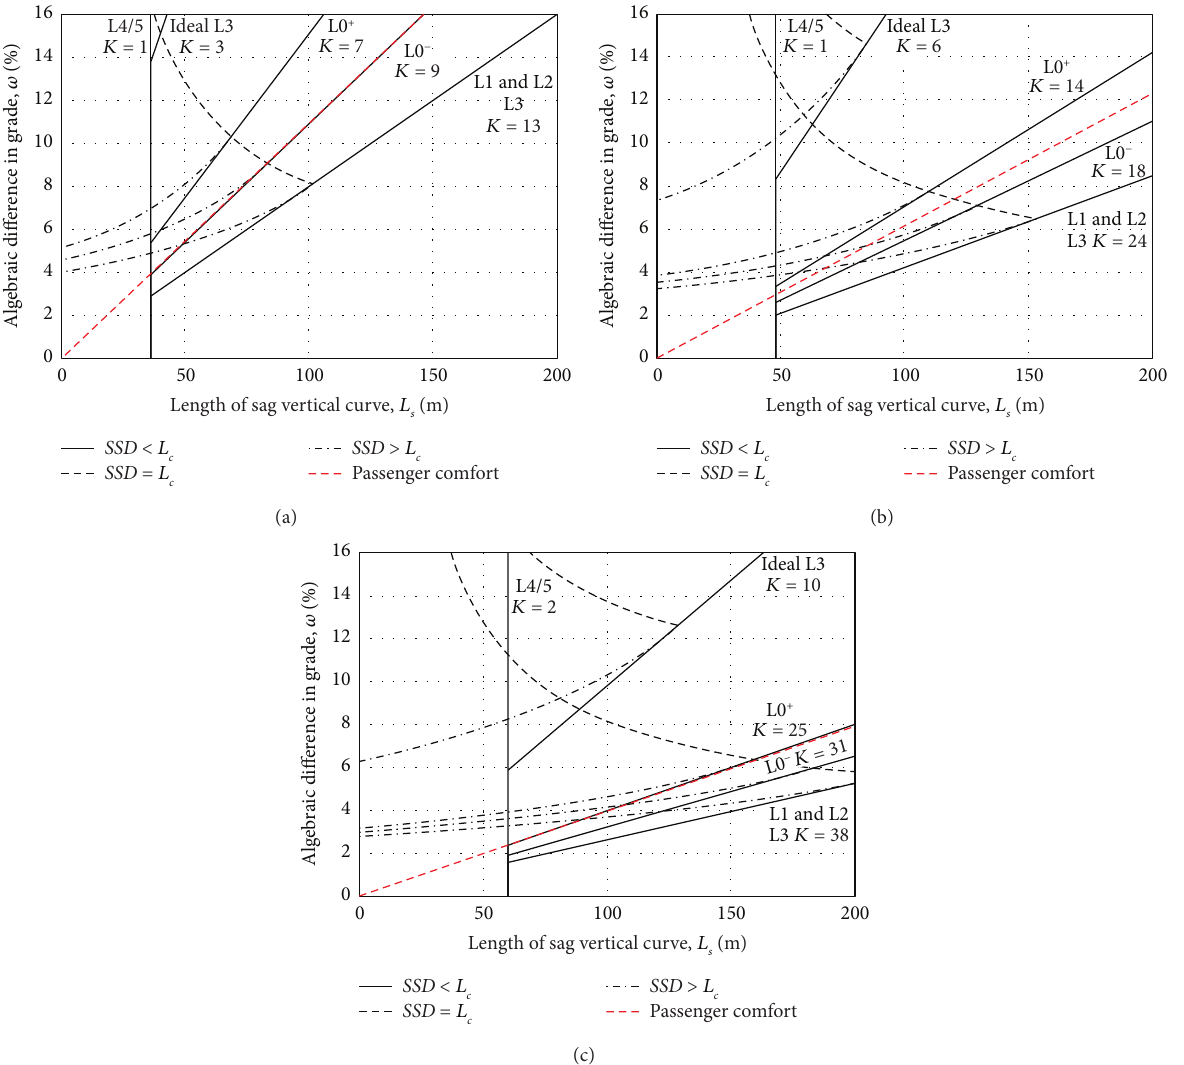
Figure 7: Design controls for sag vertical curves on open road conditions for all scenarios: (a) V � 60km/h; (b) V � 80km/h; (c) V �